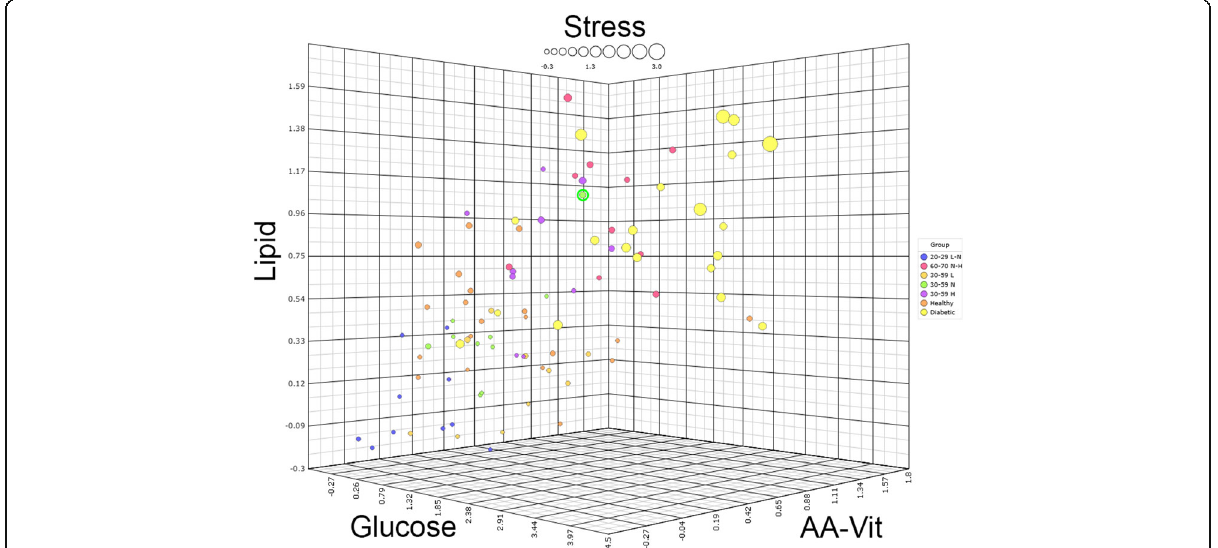
Fig. 4 The combined health space including subjects from two different studies. Three spatial axes are labeled for the domain they represent. “ AA-Vit ” stands for amino acids and vitamins. The dot size represents the “ metabolic stress ” axis of the health space. Groups labeled using their respective age intervals as well as their body fat percentage intervals, L for low, N for normal, and H for high. The male outlier (subject 12) from the first health space is again encircled in